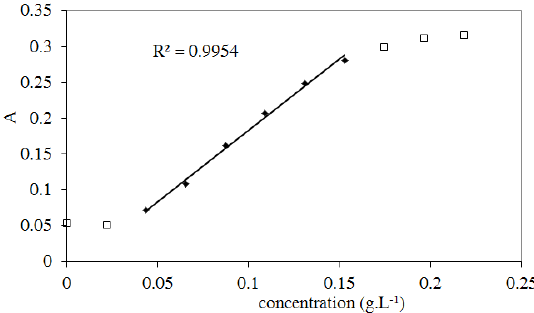
Figure 3. Calibration curve for Triton CF-21 (no humic substances).